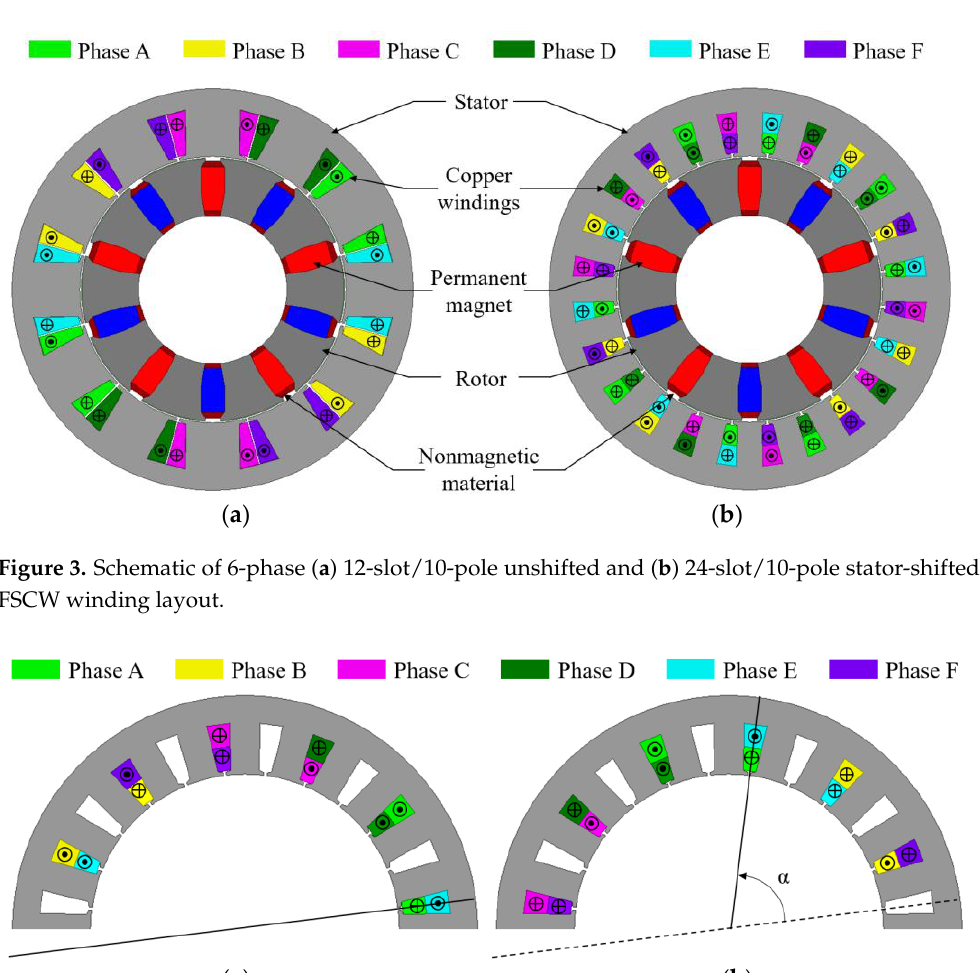
( b ) Figure 5. Total MMF distribution ( a ) profile and ( b ) harmonic spectrum of the conventional and proposed FSCW motor. To validate the simulation results of the proposed 24-slot/10- pole 6Φ -SS-FSCW-Fer- SIPMSM, the reported 6-phase 18-slot/8-pole V-type IPMSM with a 20° electrical phase shift between two three-phase windings [4] was designed and simulated using ANSYS Maxwell 2D FEA v.18.1. Figure 6 shows the designed motor with a winding layout and prototype. The simulated back electromotive force (EMF) waveforms of the A-B-C wind- ings at 2800 rpm using an in-house FEA tool were investigated and compared with the back EMF waveforms of the A-B-C windings that were measured and reported by the authors of [4]. Figure 7 shows the corresponding performance comparison. As shown, the simulated back EMF shows good agreement with the measured back EMF.